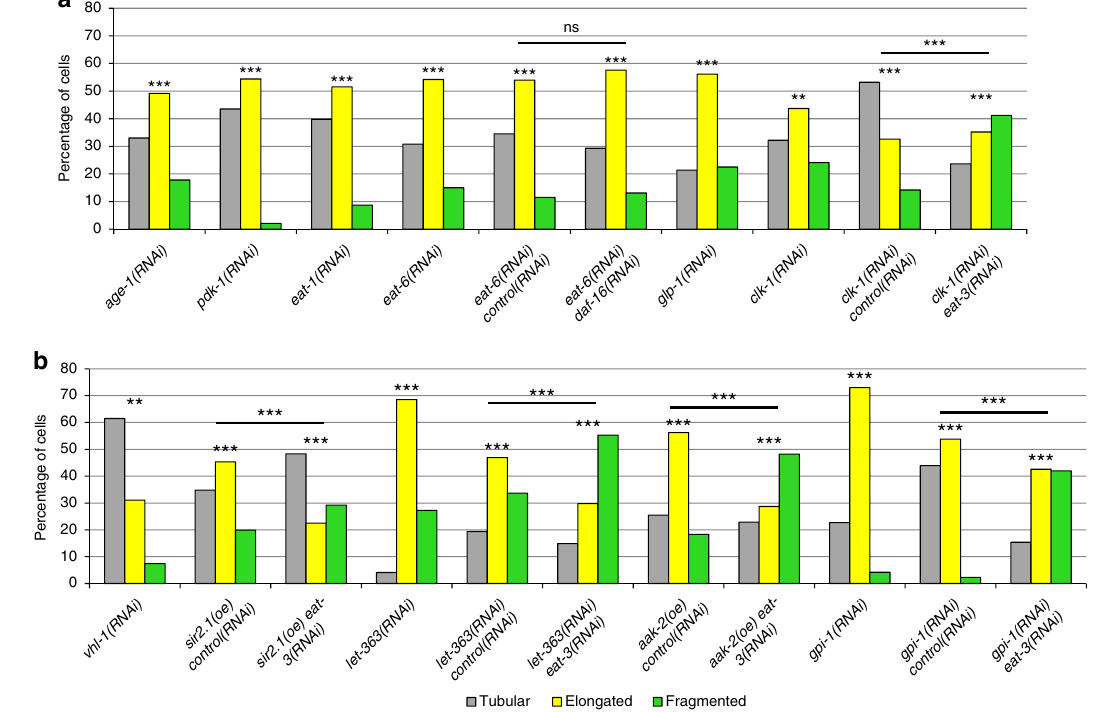
Fig. 8 Diverse life extension pathways have increased levels of elongated mitochondria. a , b The percentages of body-wall muscle cells with tubular, elongated, and fragmented mitochondria in the indicated genotypes, overexpression (oe), and RNAi treatments. P values were determined by χ 2 -test. Sample size ( n ) of muscle cells from left to right are: a 254, 239, 301, 331, 103, 110, 303, 270, 141, 148; and b 148, 181, 120, 121, 98, 114, 153, 122, 260, 264, 143. For all panels, asterisks above bars denote P value comparisons to wild-type/control; asterisks above lines denote comparisons under the lines : * P <